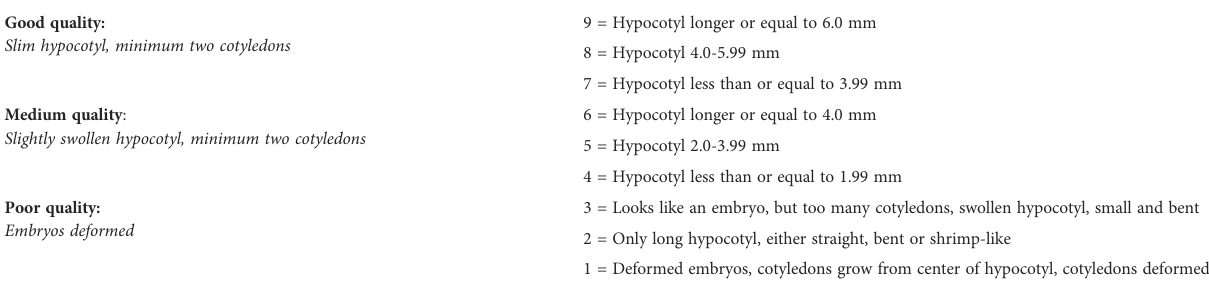
TABLE 2 Initial embryo quality score recorded before starting germination treatment. Category Initial embryo